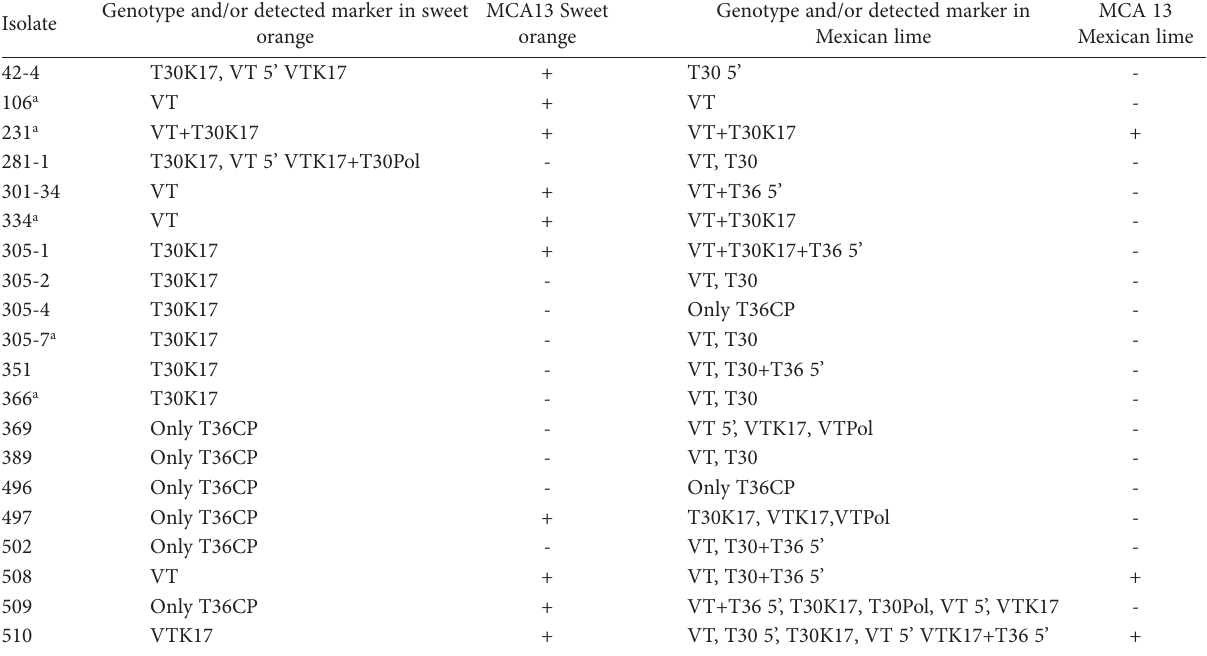
Table 2. Characterization of Chilean CTV genotypes based on marker patterns according to Hilf et al. (2005), and serological reaction to MCA13 present in sweet orange and transmitted to Mexican lime through chip-bud grafting. Genotype and/or detected marker in Isolate